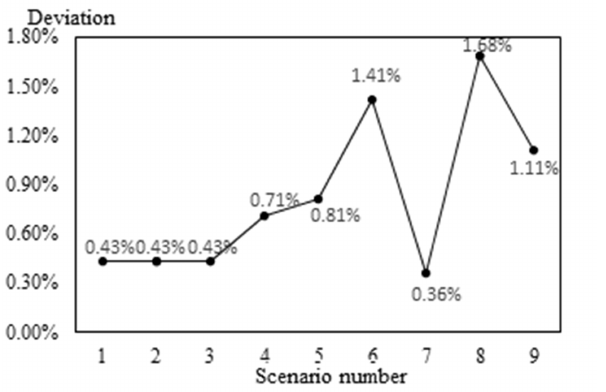
Figure 2. Relative